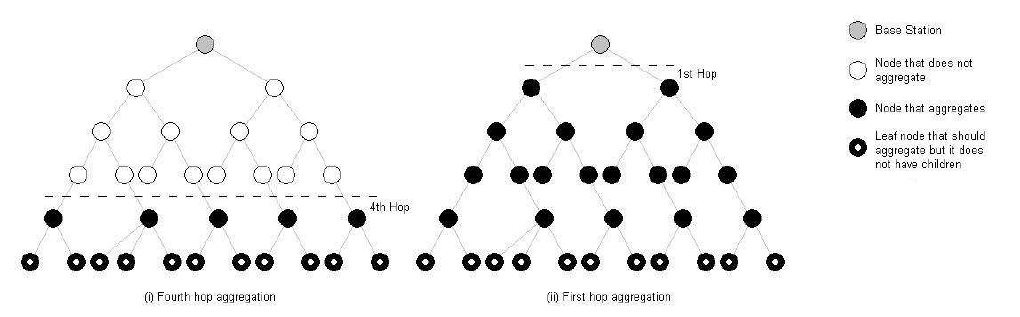
Figure 3. Adaptive fidelity: how it